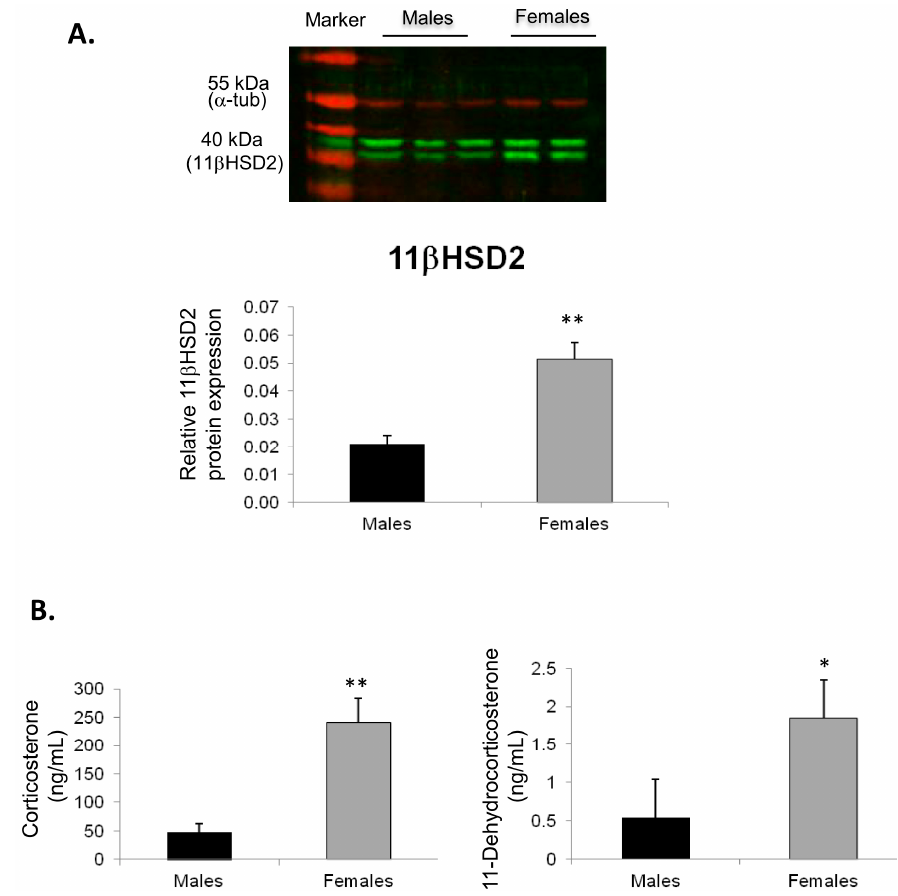
Figure 4. ( A ) Comparison of 11 β -hydroxysteroid dehydrogenase type 2 (11 β HSD2) renal protein expression between male and female adult mice. The relative protein expression of 11 β HSD2 was quantified using immunoblot analyses in kidneys of 6 adult male and 5 adult female mice. Note that the 11 β HSD2 antibody leads to the detection of two bands of 45 and 40 kDa molecular masses, the lower band corresponding to the 11 β HSD2 protein ( upper panel ). Results, expressed as the ratio of the expression of the 11 β HSD2 protein, normalized to that of the α -tubulin used as loading control, correspond to mean ± SEM ( lower panel ) , ** p < 0.01; ( B ) Comparison between corticosterone and 11-dehydrocorticosterone plasma levels between male and female adult mice. These hormonal levels were measured by liquid-chromatography coupled to mass spectrometry in tandem (LC-MSMS) in 6 adult male and 5 adult female mice. Results represent mean ± SEM. * p < 0.05, ** p < 0.01.